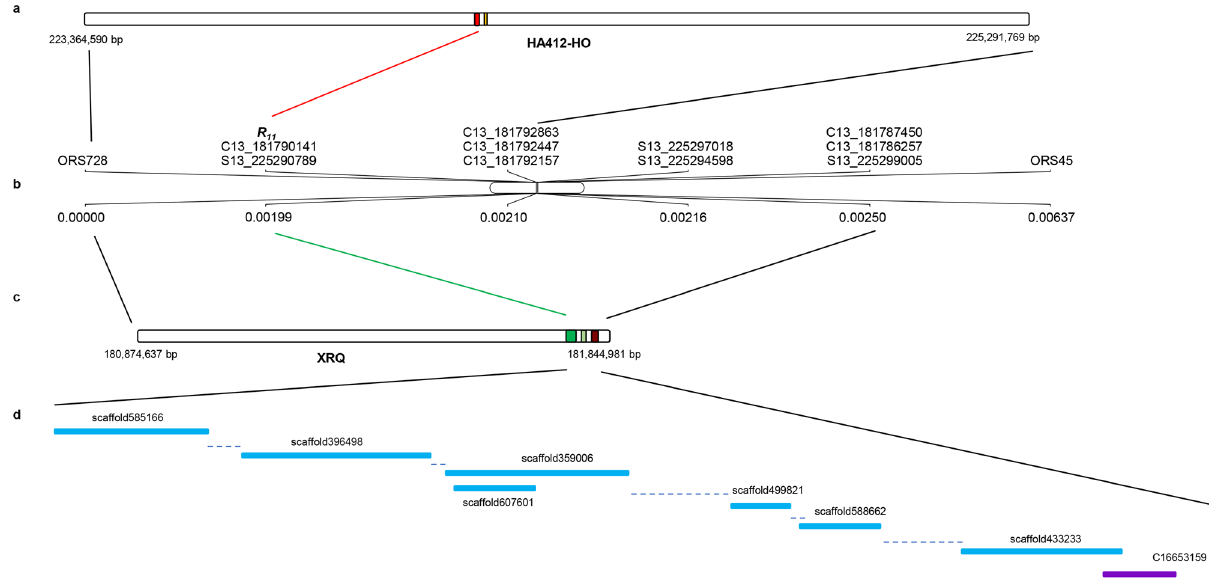
Figure 4. Illustration of R 11 gene along sunflower chromosome 13. ( a ) Extracted HA412-HO genomic region containing R 11 . Red and orange bars on HA412-HO assembly highlight candidate R 11 genes Ha412v1r1_13g051750 and Ha412v1r1_13g051760; ( b ) Fine map of R 11 on sunflower chromosome 13 showing the relative positions of R 11 and its linked markers; ( c ) Extracted XRQ genomic region containing R 11 . Dark green, light green and brown bars on XRQ assembly highlight candidate R 11 genes HanXRQChr13g0422111, HanXRQChr13g0422121, and HanXRQChr13g0422131; and ( d ) Solid purple and blue bars show the relative positions of HA-R9 contigs and scaffolds, respectively, aligned to the R 11 targeted region of the XRQ reference genome, and the dotted line represents the gap. Candidate Gene Contig and Scaffold % identity Alignment length (bp) E-valueQuery